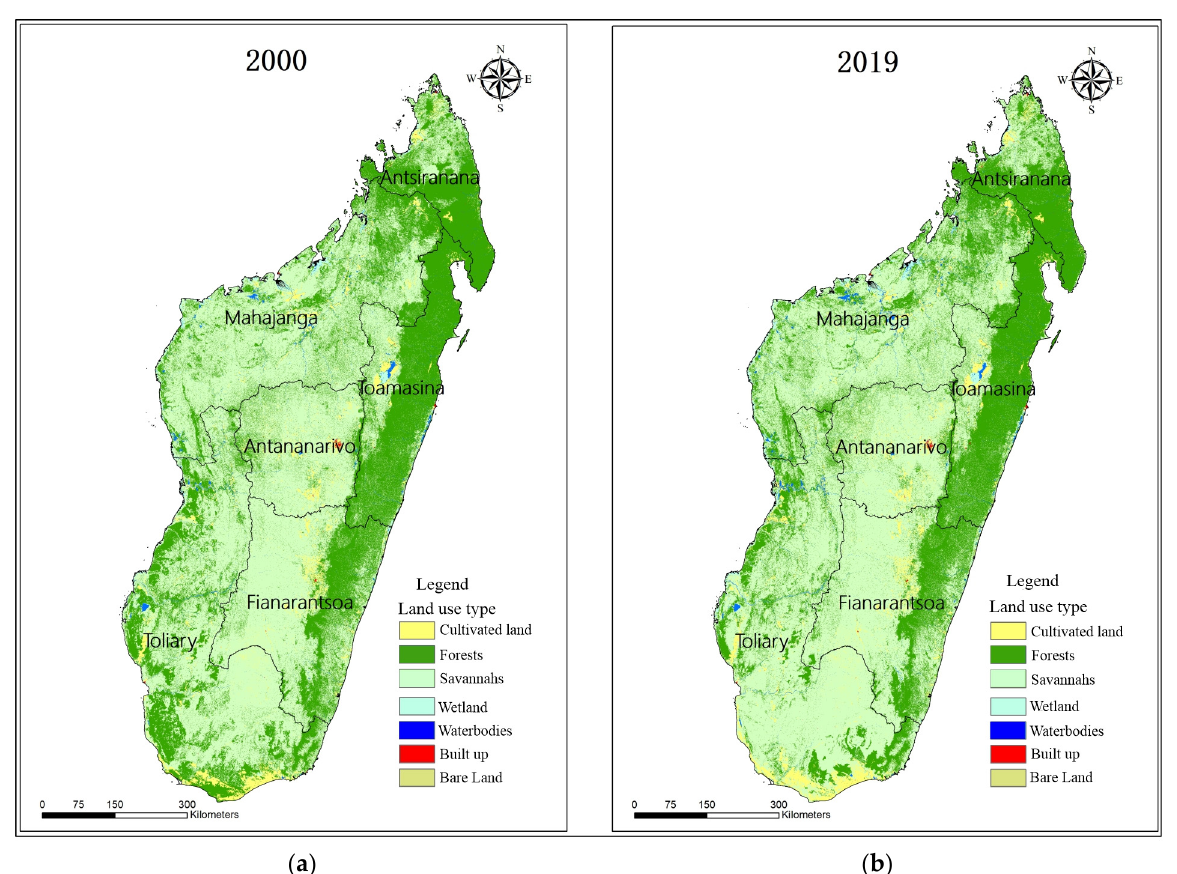
Figure 2. Madagascar island LULC spatial distribution ( a ) 2000 and ( b )